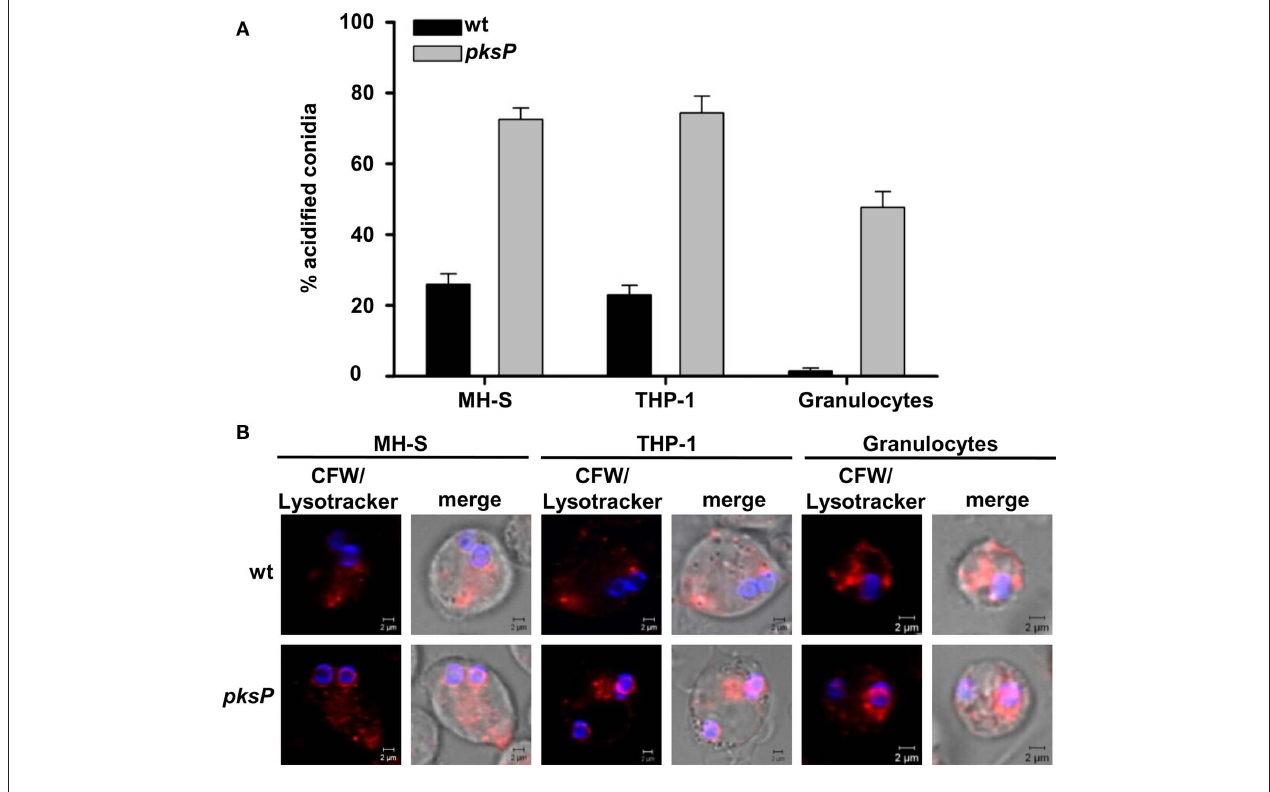
FiguRe 1 | Detection of conidia in acidified compartments after phagocytosis by MH-S and THP-1 cells, and neutrophil granulocytes. (A) Percentages of conidia present in acidic phagolysosomes. Calcofluor white (CFW)-labeled conidia were intracellularly colocalized with LysoTracker